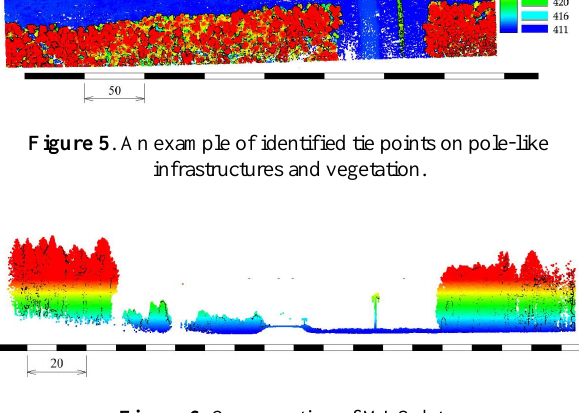
Figure 6 . Cross-section of MLS